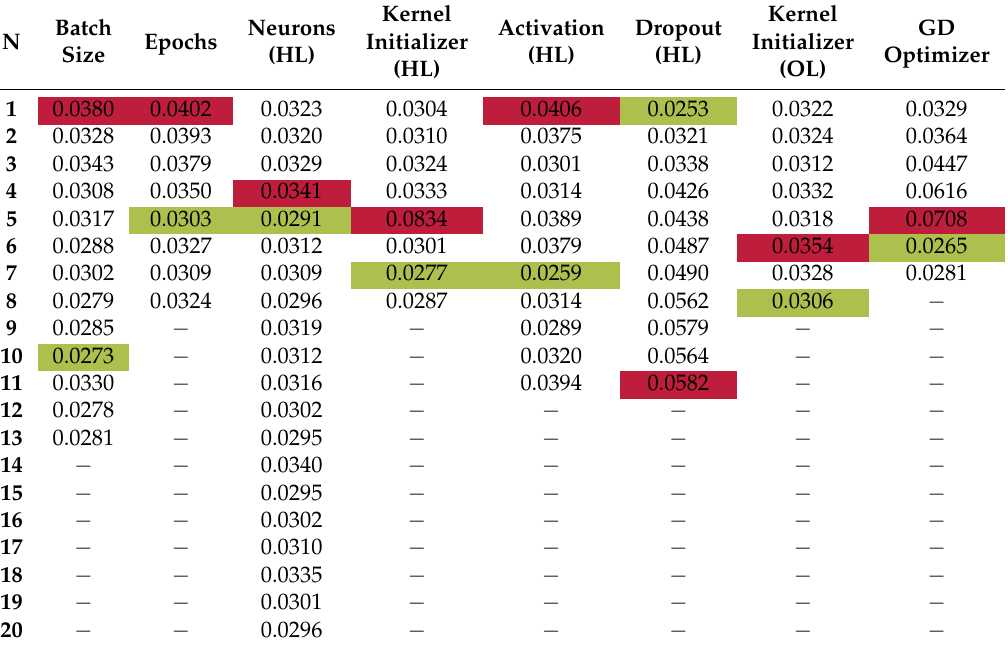
Table A5. Gridsearch training results—training MSE of material parameters.